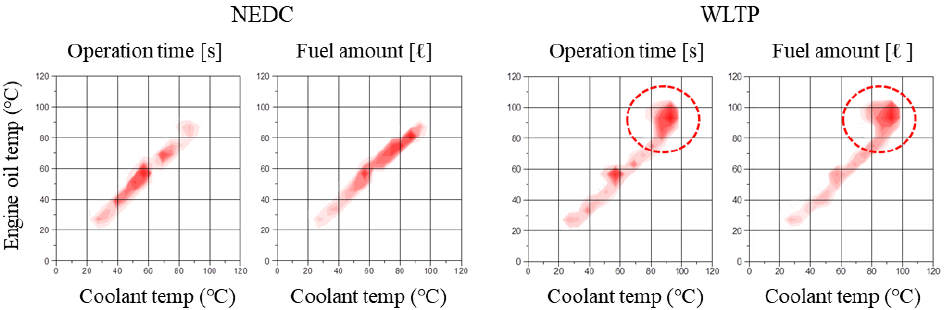
Figure 14. Operation time and fuel amount according to coolant and engine oil temperature (Diesel 1.6 VGT engine) .